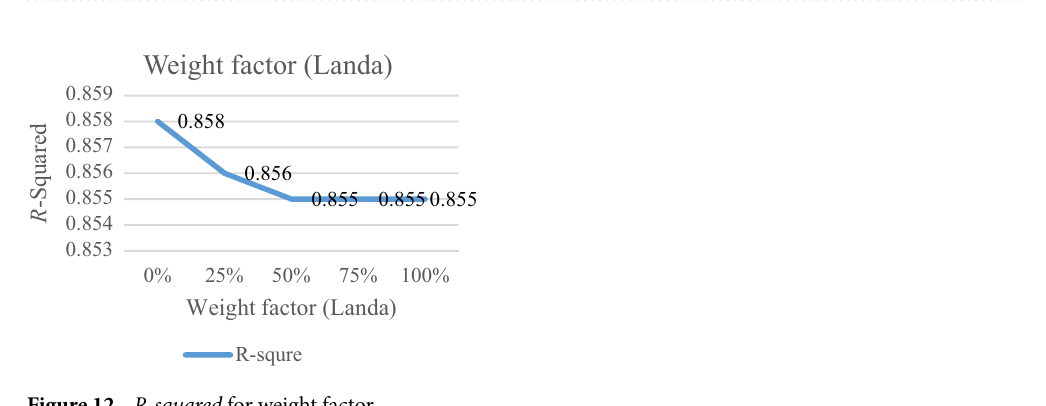
Figure 12. R-squared for weight